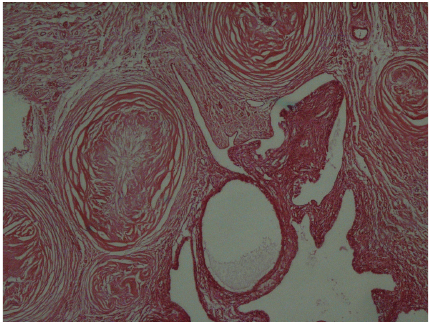
Figure 1: Right fallopian tube showing thickened wall containing many concentric fibroses.